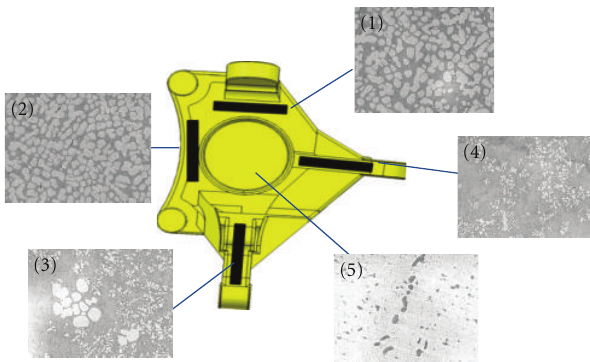
Figure 31: Microstructures of knuckle at each position ( S f = 40%, 588 ◦